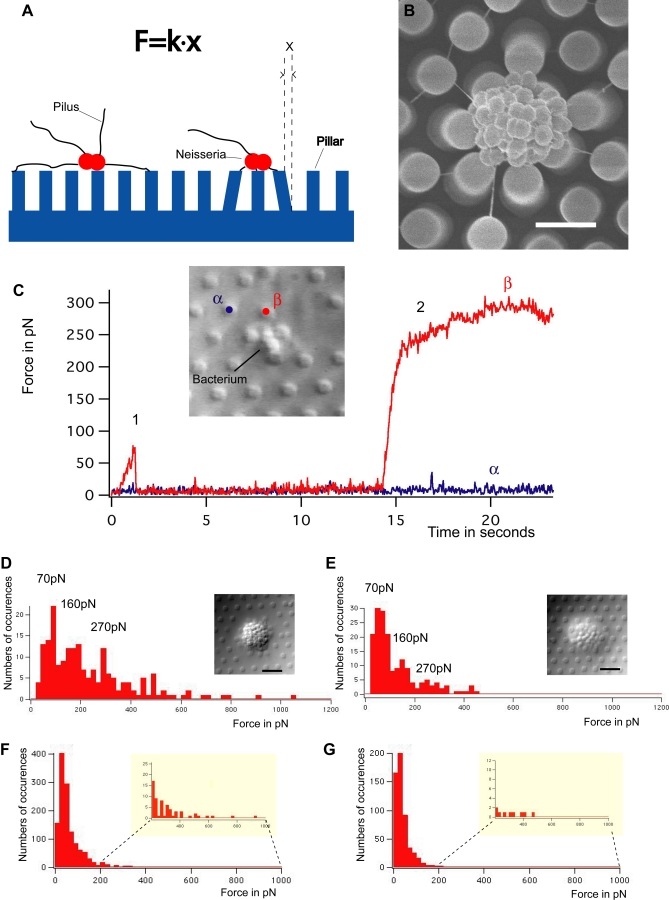

N. gonorrhoeae Tfp Can Exert Forces in the nN Range(A) Schematic of the force measurement assay used in this study.(B) SEM micrograph of a microcolony with Tfp pulling on pillars (here the pillars are molded in polydimethylsiloxane, a widely used, silicon-based polymer, to enable SEM). Scale bar = 2 μm.(C) Time course of the force exerted on a pillar. (1, trace β): short-lived, low-force pulling event. (2, trace β): long-lived, high-force event. Trace α shows a neighboring pillar that did not move.(D and E), Histograms of the forces recorded in static studies for WT MS11 in DMEM (D) or in DMEM + BSA (E). Inserts are differential interference contrast images of representative microlonies in the samples. Scale bar=5 μm.(F and G), Histograms of the forces recorded in dynamic studies of WT MS11 in DMEM (F) or DMEM + BSA (G). Inserts represent close-ups of the tail of each force distribution curve (forces between 200 pN and 1000 pN).